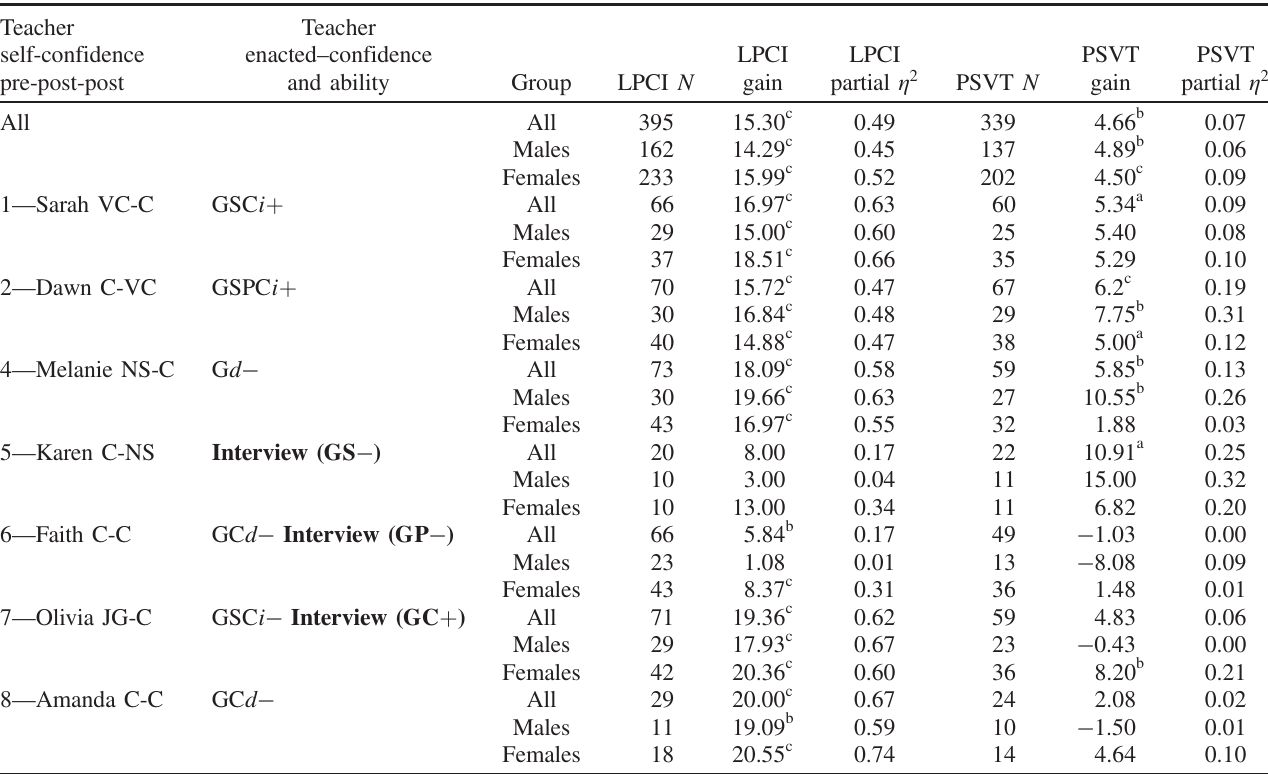
TABLE VII. Students ’ percentage correct gain scores on LPCI and PSVT-Rot by teacher. Note that gains are calculated by post-pre. Significance determined by repeated measures ANOVA. Teacher self-confidence